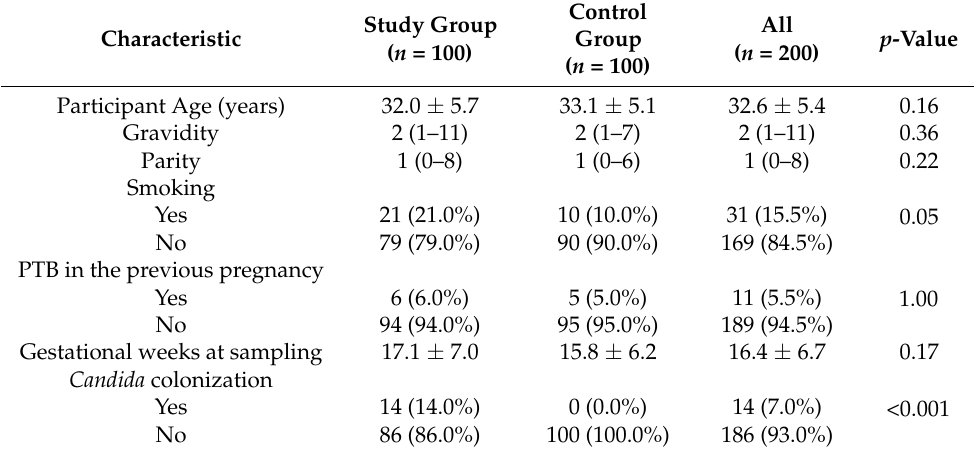
Table 1. Characteristics of 200 asymptomatic pregnant women, screened for BV using Gram-stained smears and the OSOM ® BVBLUE ® Test (data presented as numbers and percentages, mean ± standard deviation, or median (range); unpaired two tailed t-tests performed for continuous variables, Fisher’s exact tests for binary variables, and Mann–Whitney U-Tests for ordinary variables; BV, bacterial vaginosis; PTB, preterm birth).